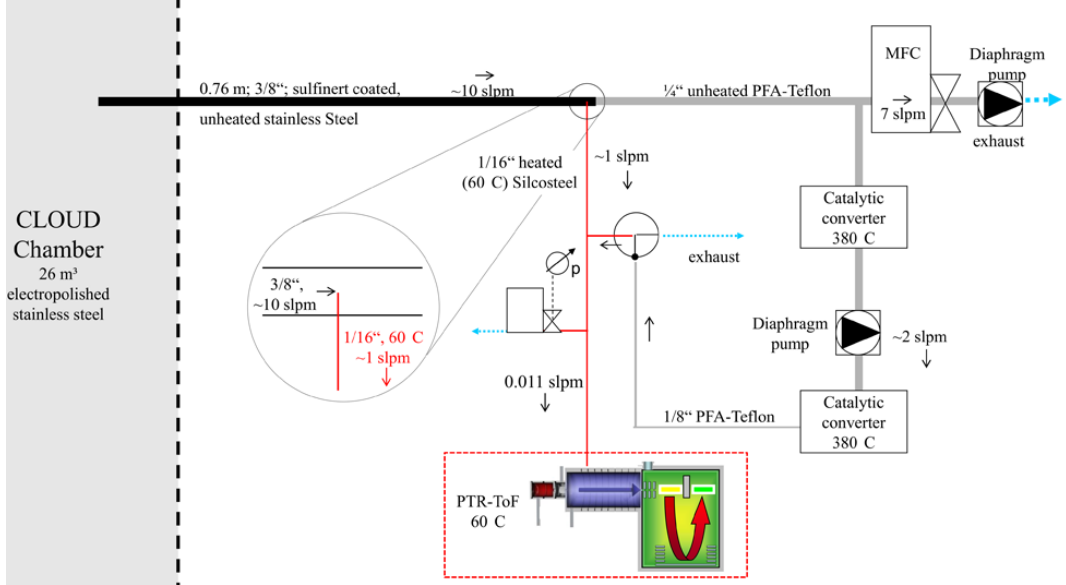
Figure 2. Schematic drawing of the PTR-Q-MS/PTR-ToF-MS inlet system during the various CLOUD campaigns.